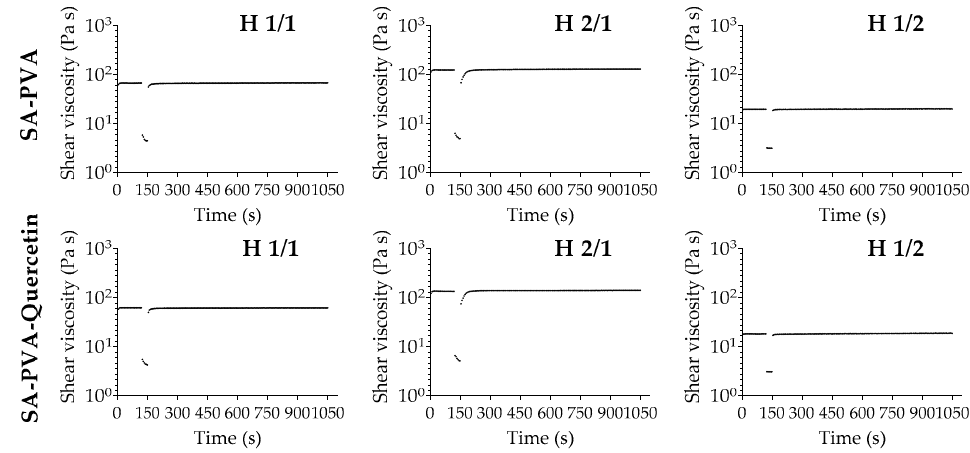
Figure 4. Thixotropy analysis of unloaded (top row) and quercetin-loaded (bottom row) SA-PVA hydrogels.